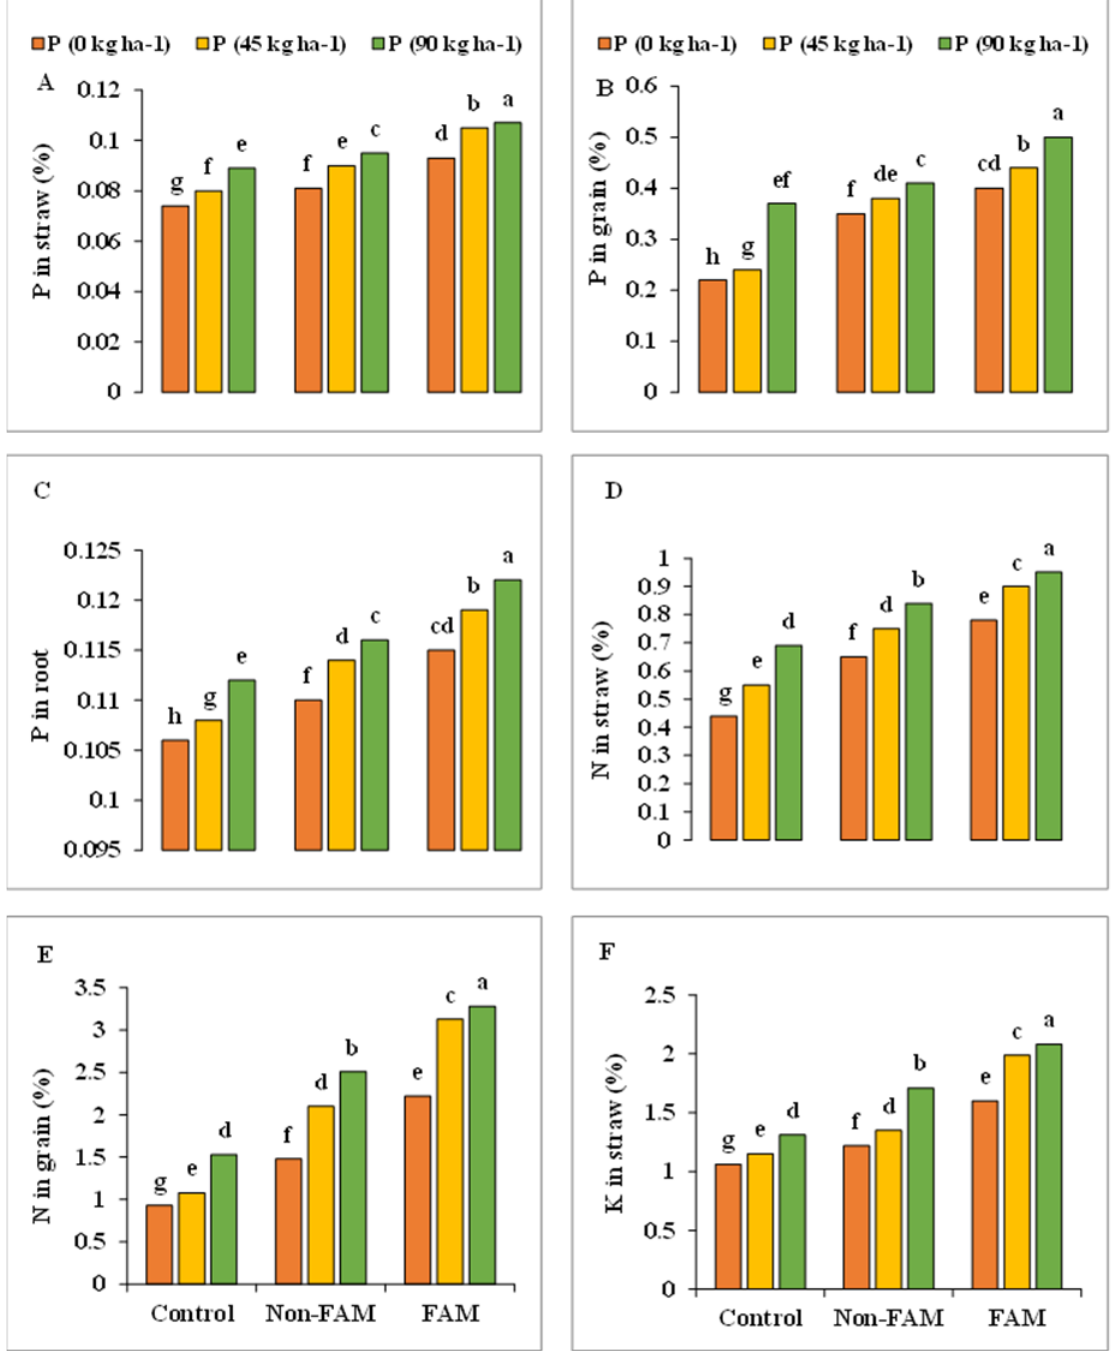
Figure 5. Combined use of fermented/non-fermented animal manure and phosphorus fertilizer on chemical parameters of wheat. ( A – C ) P in straw, grain and root, ( D , E ) N in straw and grain and ( F ) K in straw. Columns with different letters are significantly different from one another at a level of significance of p < 5%.